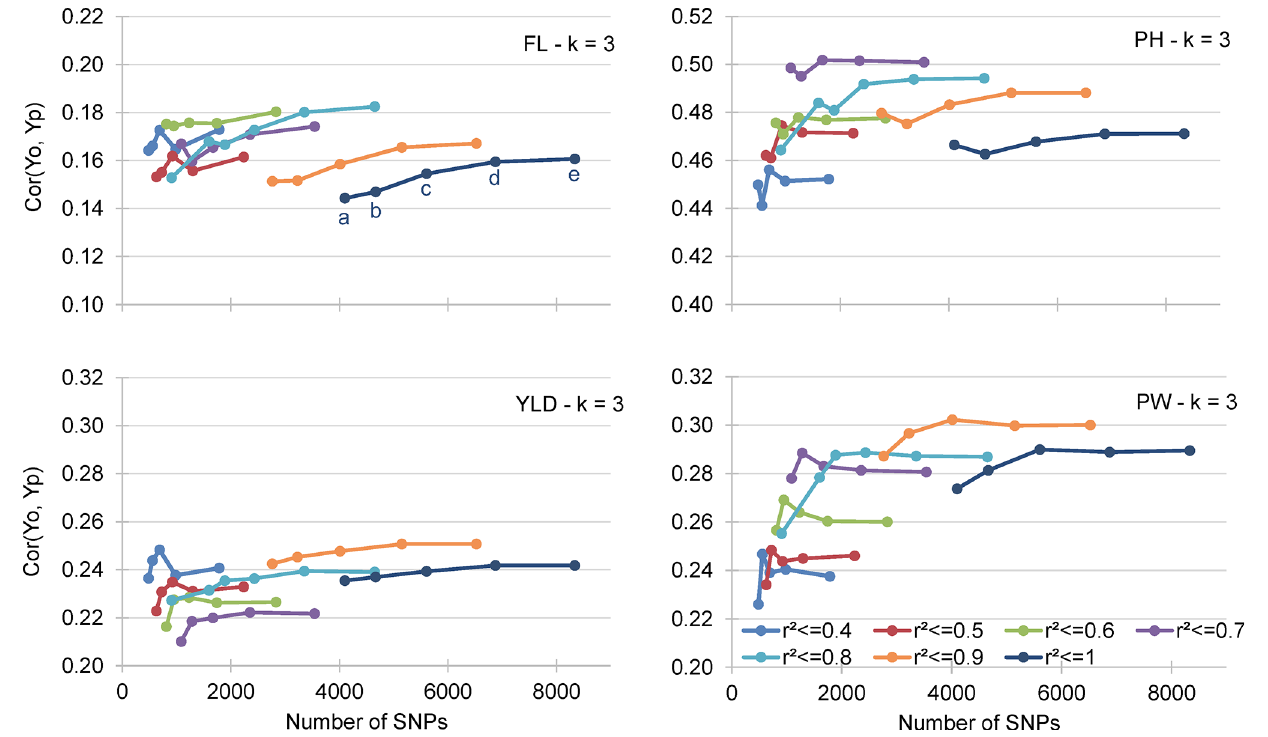
Fig 5. Mean correlation between GEBV obtained by cross validation of the training data set (Yp) and the observed BLUP values of the validation data sets (Yo). The results for days to flowering (FL), plant height (PH), panicle weight (PW) and grain yield (YLD) and 35 incidence matrices are presented.